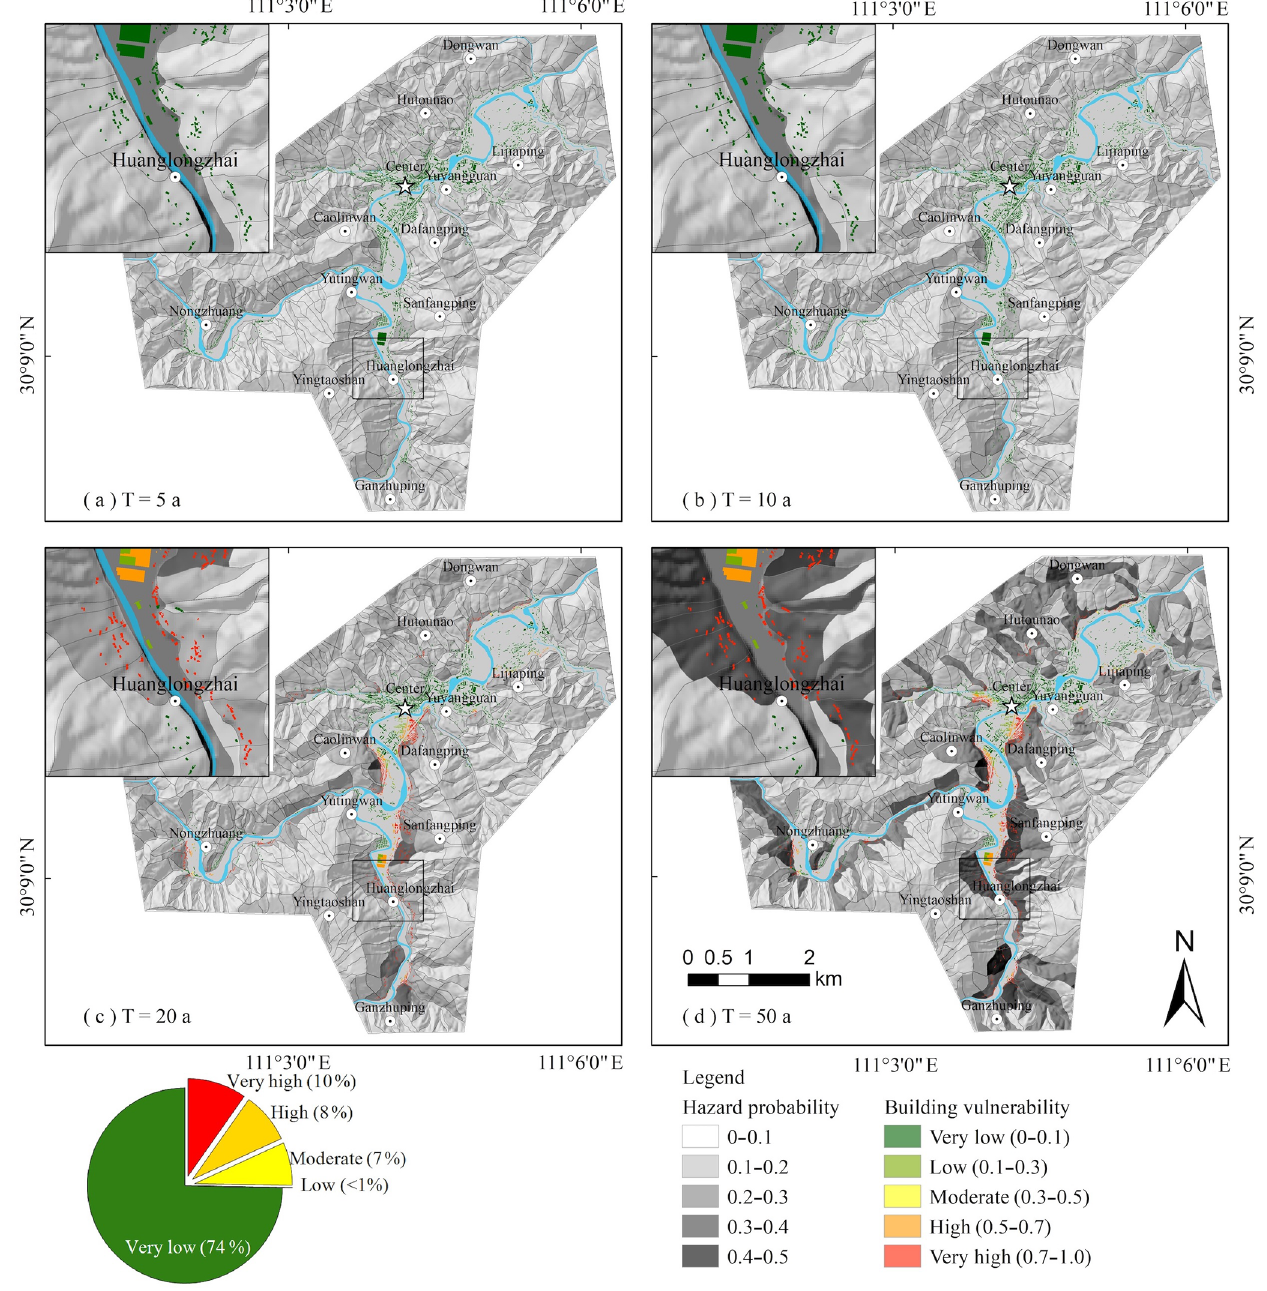
Figure 13. Buildings exposed to landslides, vulnerability distribution map for four return periods (5, 10, 20, and 50 years), and size scenario of landslide volume equal to or greater than 50000m 3